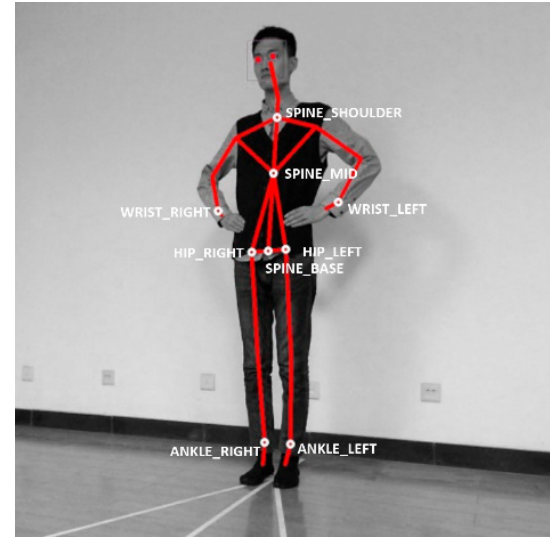
Figure 2. The selected joints used for the BESS test.